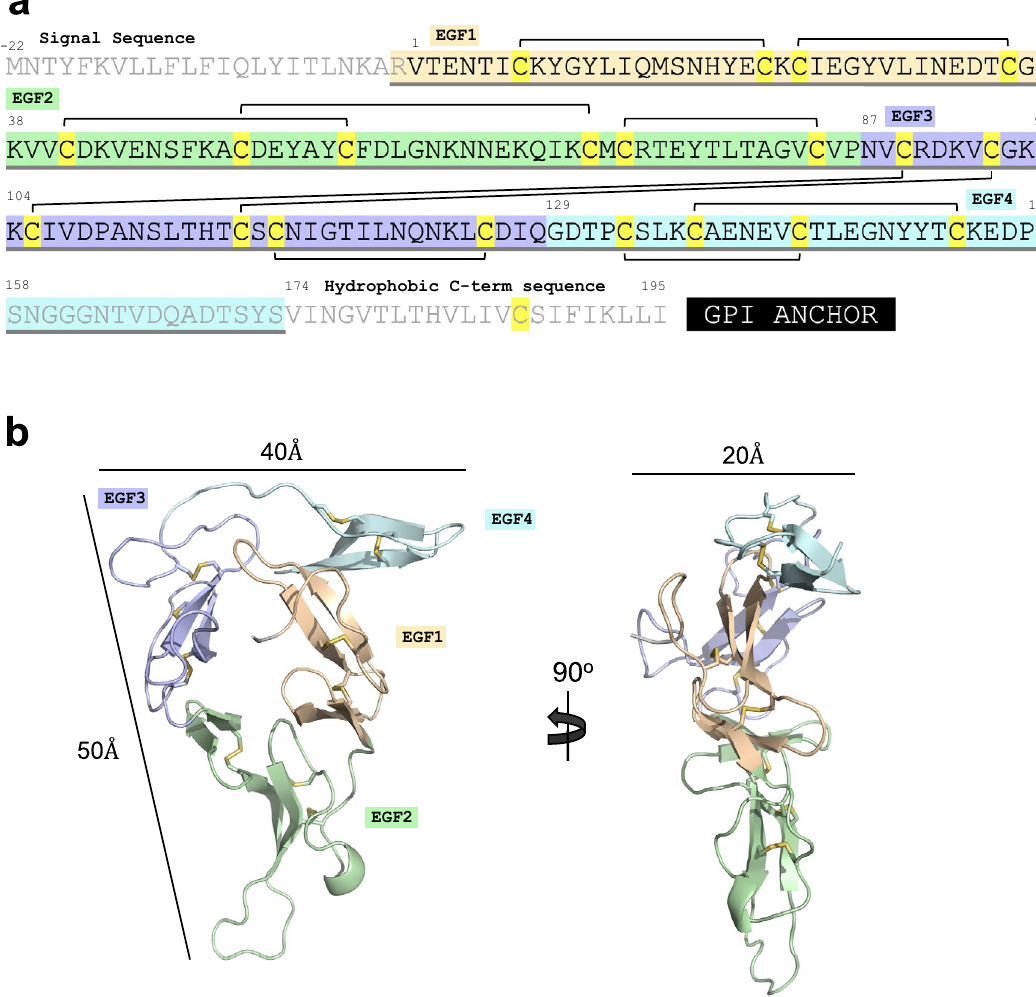
Figure 1. Pfs28 crystal structure. ( a ) Amino acid sequence of Pfs28, depicting N-terminal signal sequence, EGF-like domains 1–4, and the hydrophobic C-terminal sequence that is the site of GPI anchor attachment. Residues are shaded in wheat, green, purple, and blue according to EGF-like domain. Residues included in the construct are underlined in grey, residues that are resolved in the structure are indicated in black, while residues not present in structure are indicated in grey. Cysteines are highlighted in yellow and the disulfide bridging pattern is indicated by black brackets. ( b ) Cartoon representation of Pfs28 with the triangular arrangement of EGF-like domains 1–4 colored wheat, pale green, light purple, and pale cyan and the ten disulfide bridges indicated as yellow